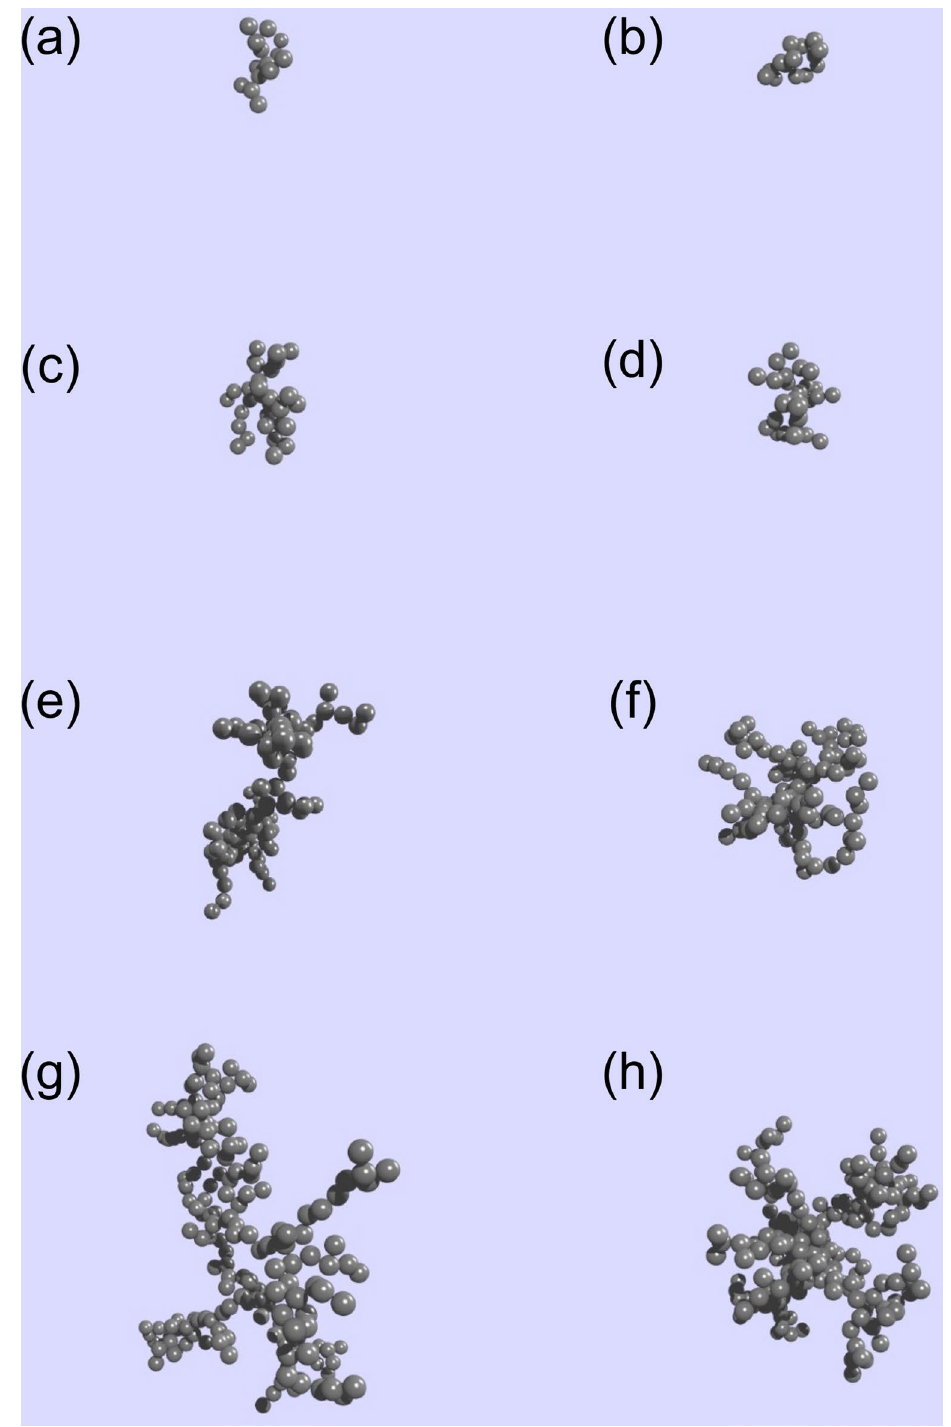
Figure 4. Examples for colloidal aggregates constructed using a tunable diffusion limited aggregation software 51,52 . D f = 1.75 ( a , c , e , and g ) and 2.05 ( b , d , f , and h ) formed from 15 ( a , b ), 30 ( c , d ), 100 ( e , f ), and 200 particles ( g , h